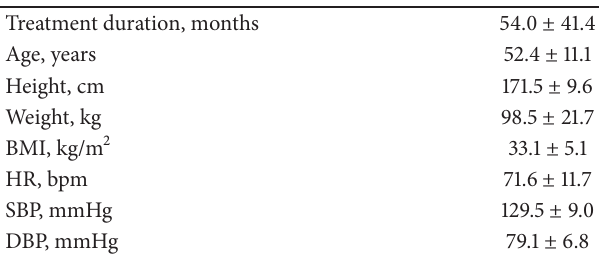
Table 1: Patient